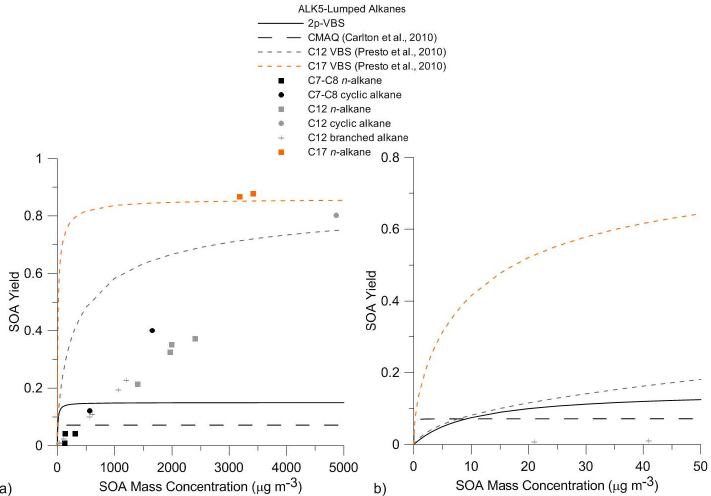
Fig. 6. Evaluation of 2p and 2p-VBS parameterizations for lumped alkanes ( ≥ C6). Theoretical yield curve (SOA yield vs. SOA mass concentration) for M o up to 5000µgm − 3 (a) and M o up to 50µgm − 3 (b) ; data from Lim and Ziemann